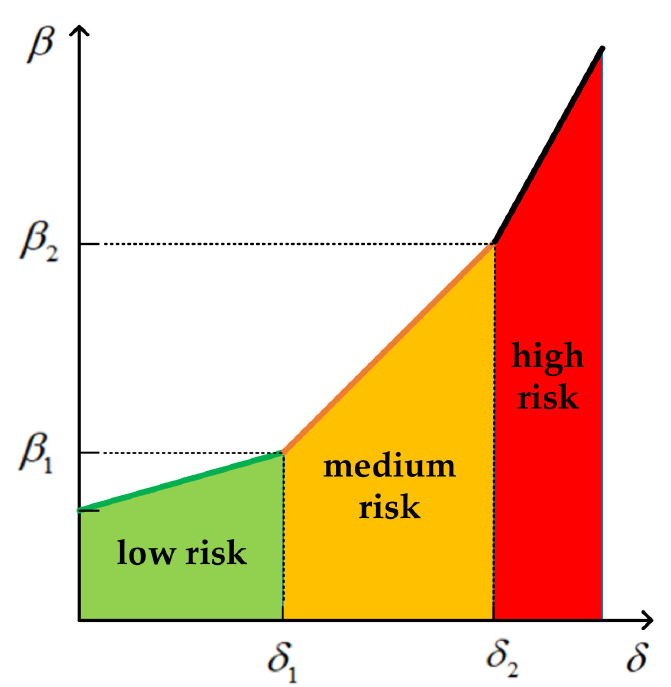
Figure 2. Relative disturbance penalty coefficient function